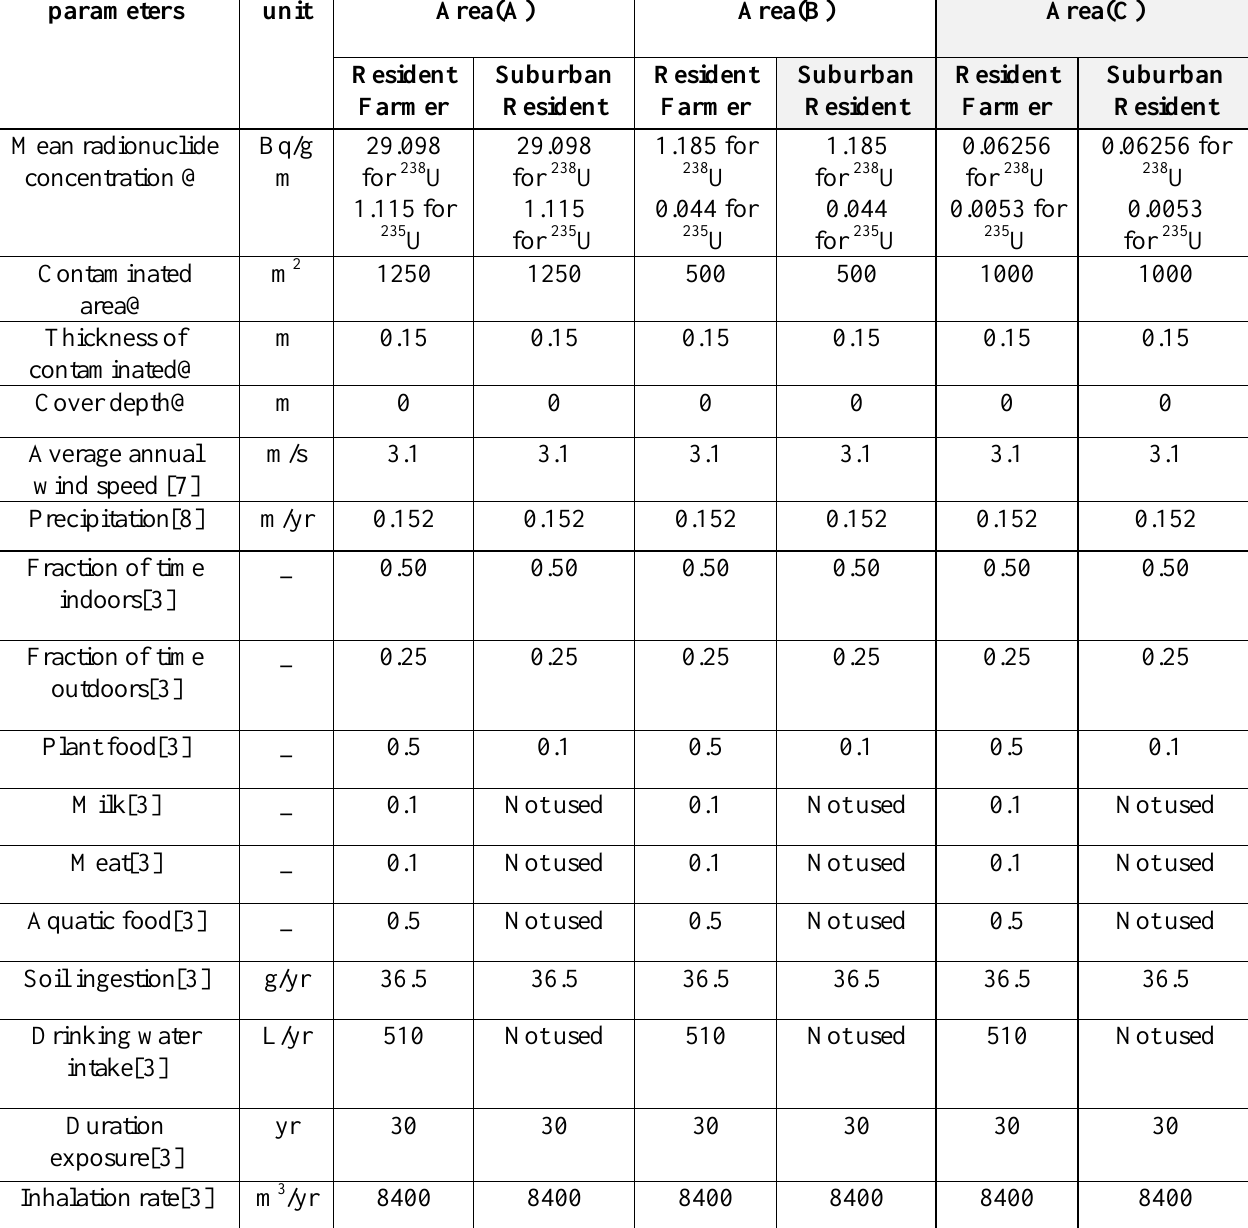
Table 2: The input parameters for RESRAD used to calculate the dose of contaminated area.